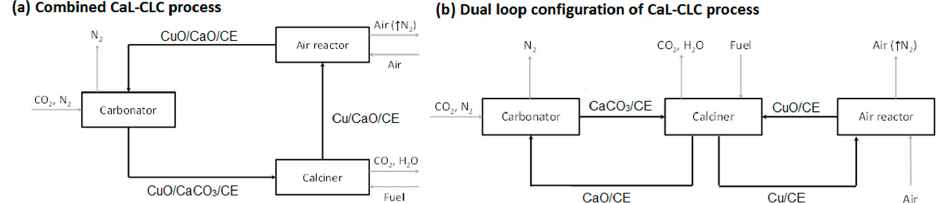
Figure 1. Schematic of the CaL-CLC process in a ( a ) combined configuration; or ( b ) dual loop configuration. Black and gray arrows represent flow of solids and gases, respectively.